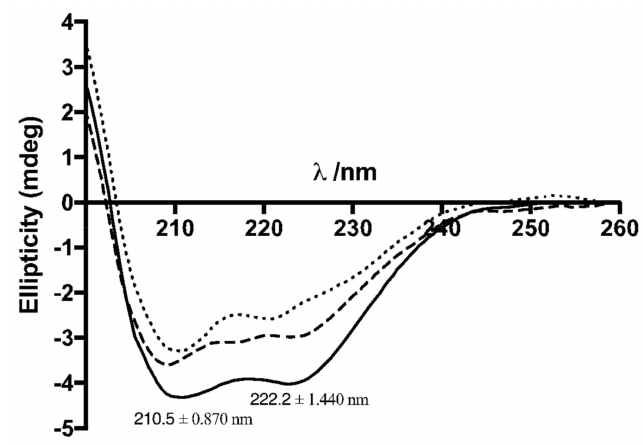
Figure 3. Circular dichroism (CD) spectra of non-encapsulated insulin ( ___ ), uncoated NPs (—) and chitosan-coated NPs ( ... ) in the Far UV range.